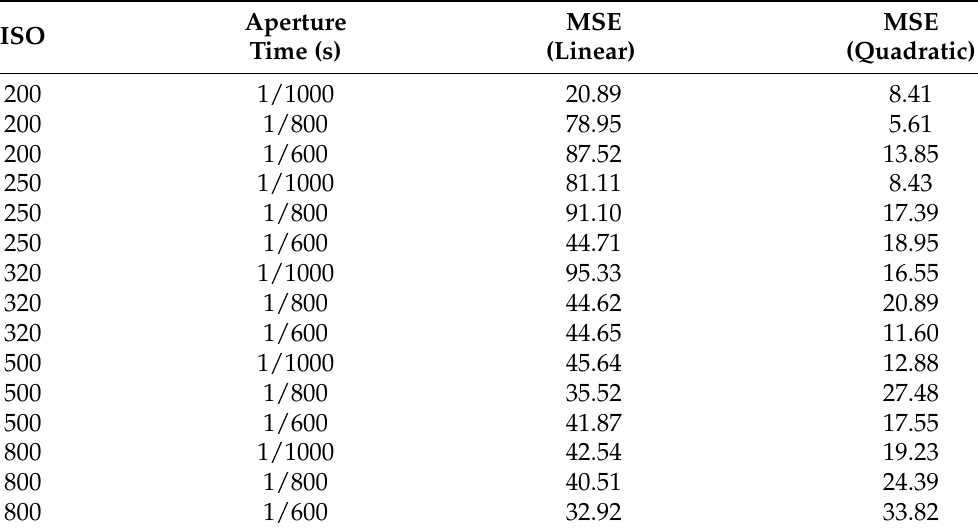
Table 1. Comparison of the Calculated Temperature with the Blackbody Furnace.